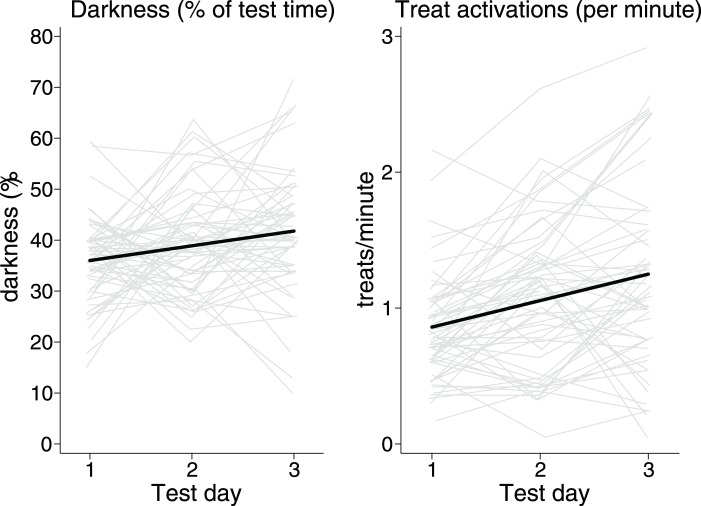
Individual differences in prevention (safety) and promotion (gains) success (black lines are population trends; grey lines are individual trajectories).Over the course of 3 test days, rats achieved progressively more darkness and treats (P<0.01 and P<0.001, respectively). They also showed significant individual differences in their mean responses of both behaviors (P = 0.001 and P<0.001, respectively).